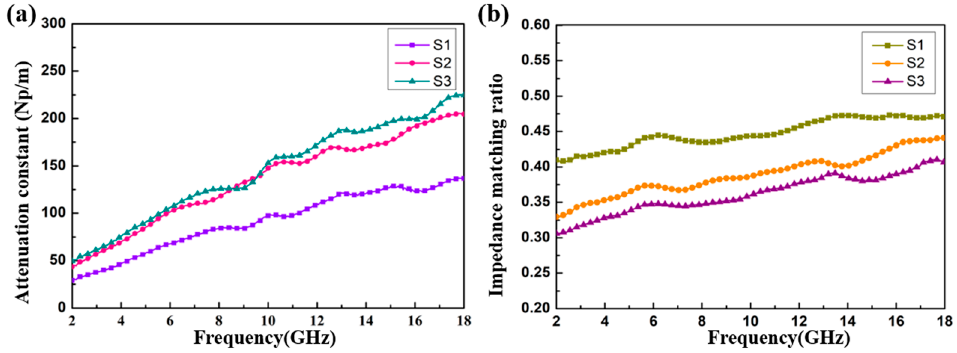
Figure 10. ( a ) The attenuation constant and ( b ) impedance matching ratio of the samples.